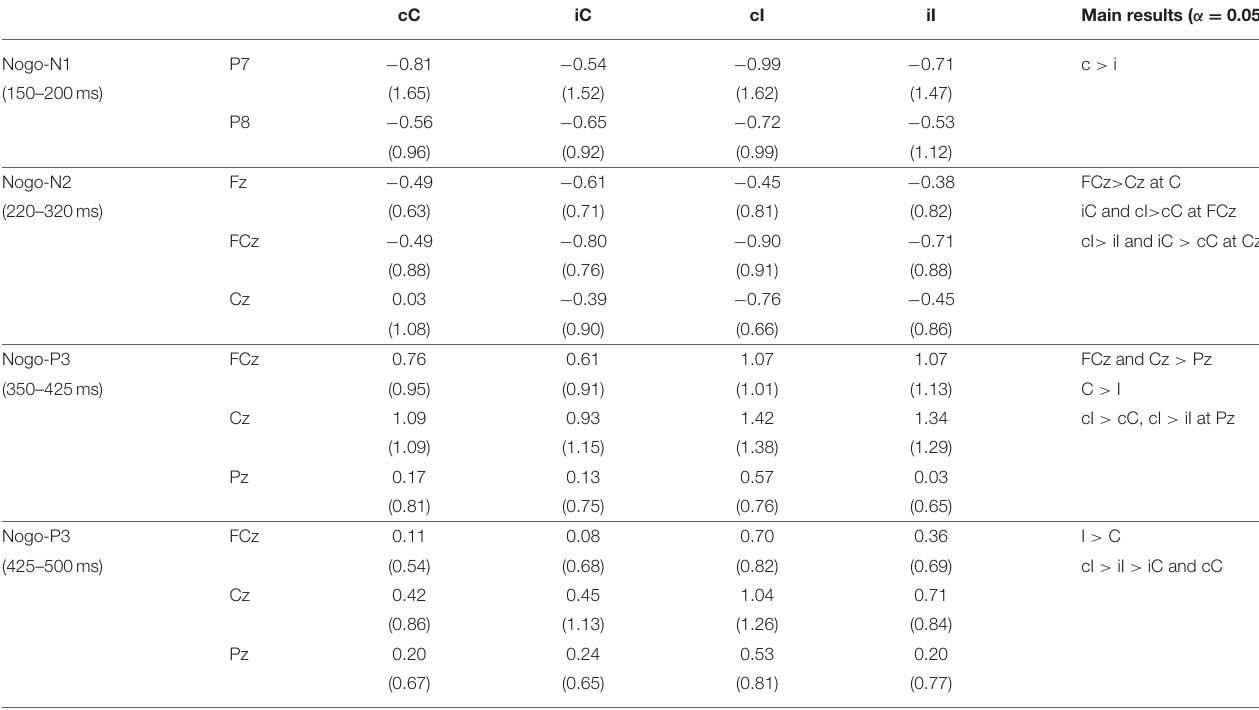
TABLE 3 | Means (SD) of ERP amplitudes for Nogo-stimuli. cC iC cI iI Main results ( α =